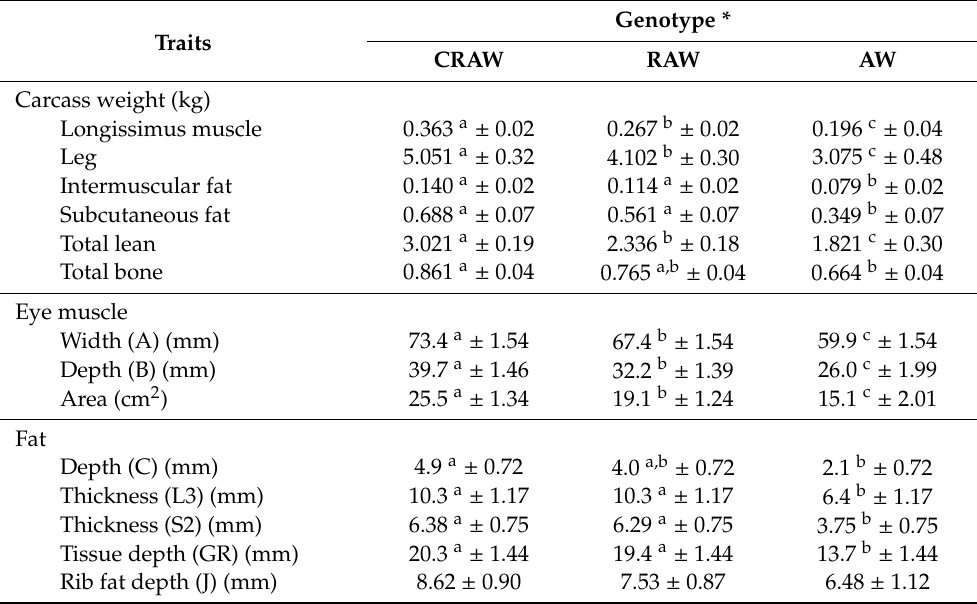
Table 3. Means ( ± SEM) dissected leg, loin cuts, longissimus muscle, and fat measurements of the first backcross callipyge Awassi–Rambouillet (CRAW), Rambouillet-Awassi (RAW), and Awassi (AW) lambs.